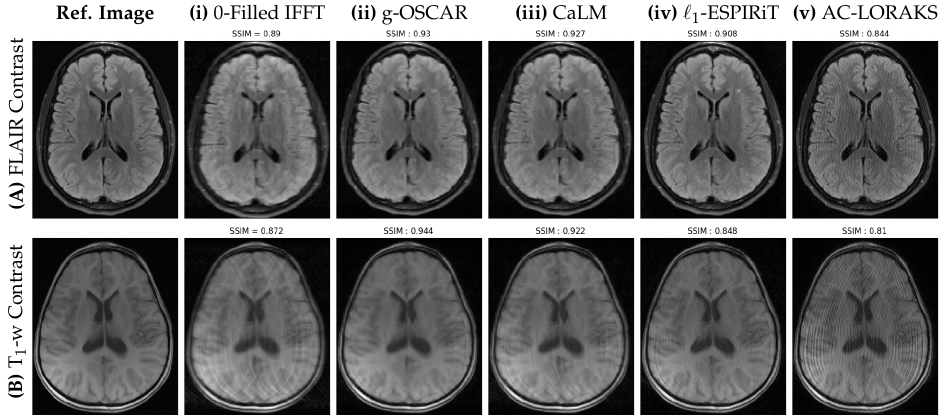
Figure 4. Retrospective results for a single slice of FLAIR ( top row ) and T1 weighted ( bottom row ) images of the brain fastMRI data set obtained using the Cartesian mask shown in Figure 3A with UF = 4, corresponding to AF 4. The fully sampled Cartesian reference and the different methods (Zero filled Inverse, g-OSCAR, CaLM, L1-ESPiRIT and AC-LORAKS) are shown from left to right and the SSIM scores are indicated to reflect the performance of each method. Version March 9, 2021 submitted to Journal Not Specified 14 of 20